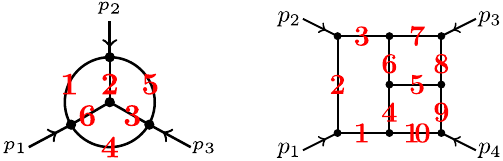
Fig. 3 Examples of Next-to-Next-to Maximal loop topologies at three loops, Mercedes-Benz (left) and tennis-court (right) topologies. The red label corresponds to the propagator